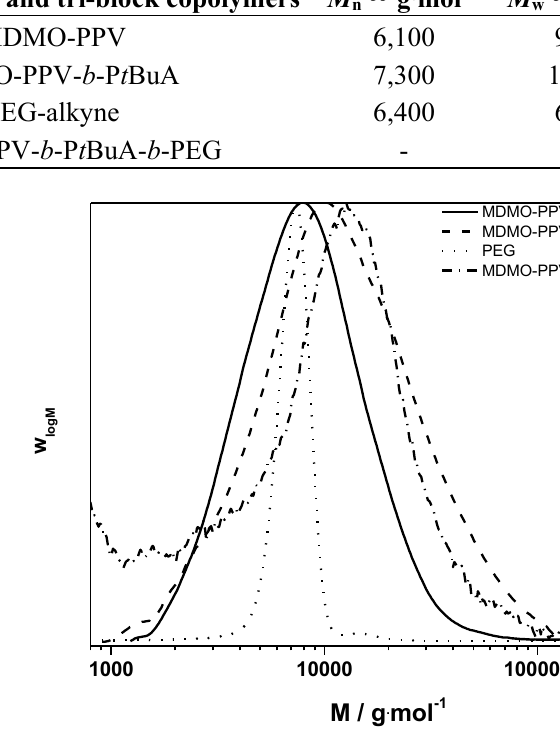
Figure 8 . Molecular weight distributions of the clicked MDMO-PPV- b -P t BuA- b -PEG triblock copolymer and its